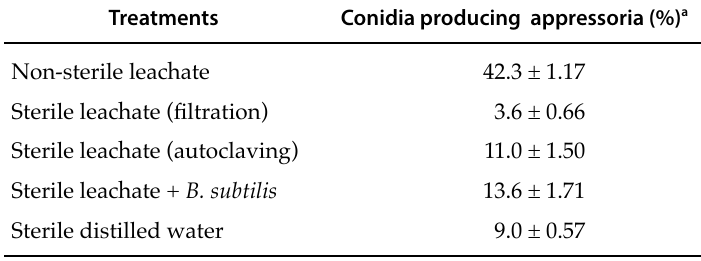
Table 6. Results of Experiment 3a (Table 1). Mean percentage of Colletotrichum godetiae conidia forming appressoria after germination in sterile distilled water, non-sterile olive leachate, sterile olive leachate obtained by filtration or autoclaving, sterile leachate obtained by filtration and amended with cells of Bacillus subtilis and sterile distilled water (control), after 24 h of